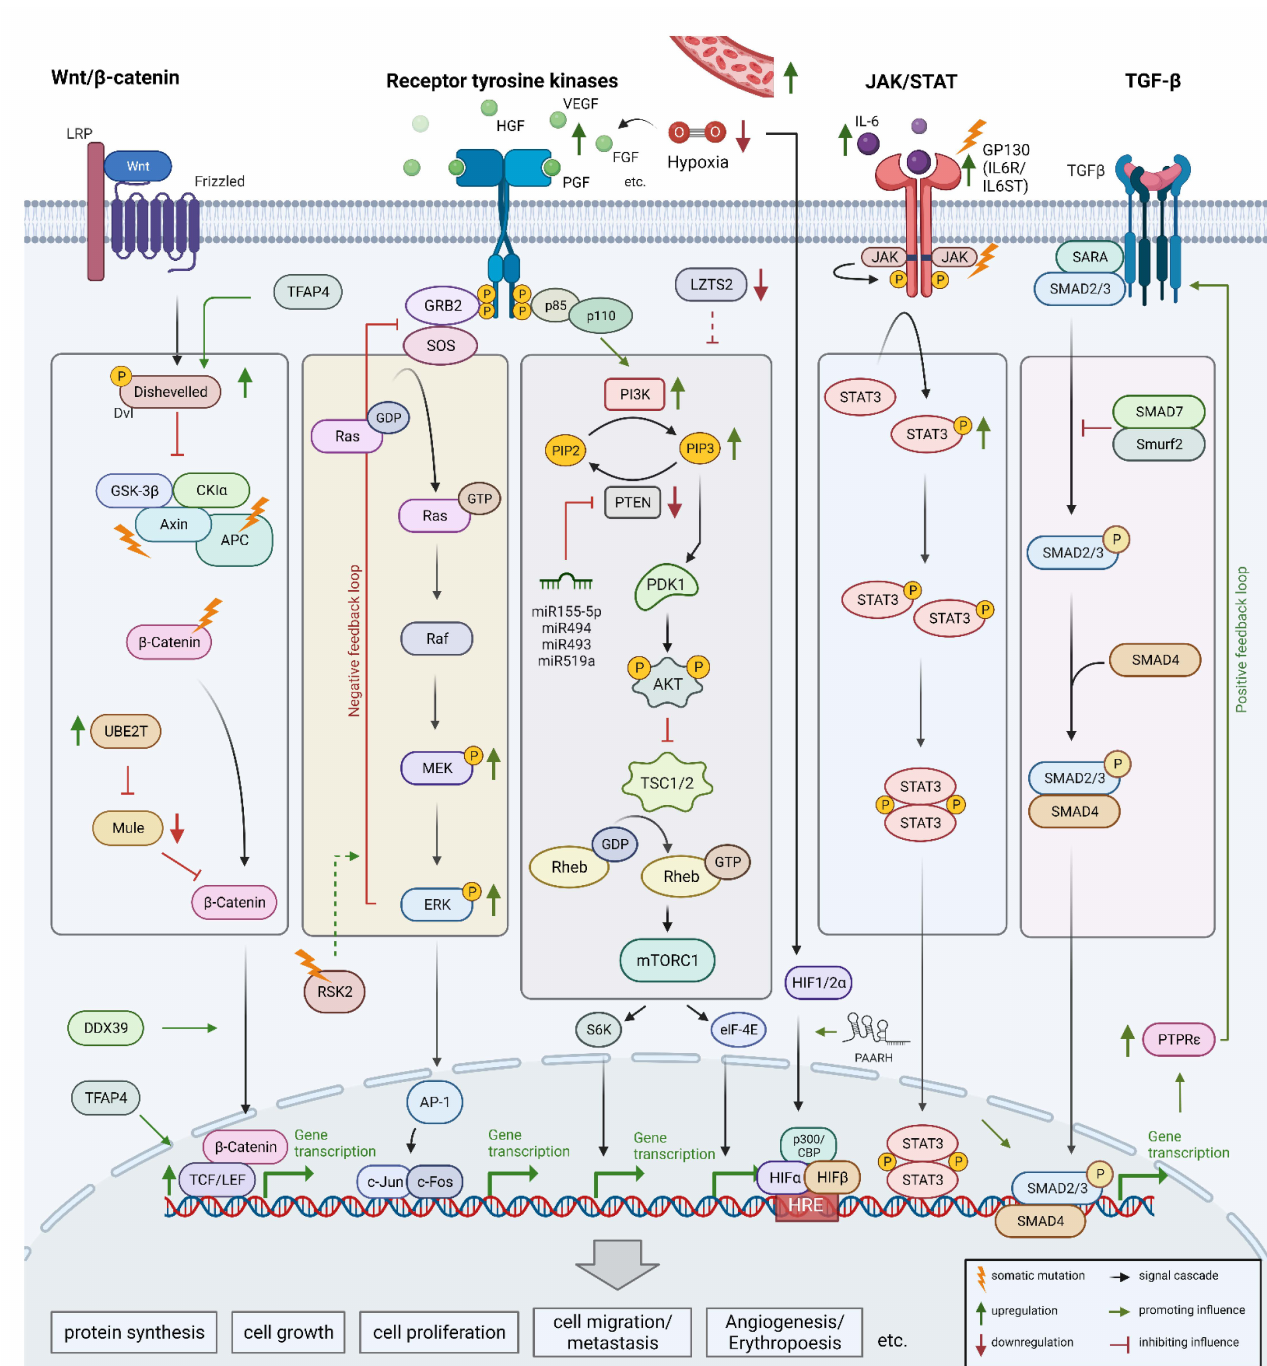
Figure 4. Most likely dysregulated key-signaling pathways are in HCC carcinogenesis. The occur- rence of distinct somatic mutations and the influence of either inhibiting or activating factors all favor the constitutive activation of significant signaling pathways. Consequently, the cell evades any regulatory mechanism and strongly promotes tumor-typical properties including cell growth, cell proliferation, migration, and metastasis. Thus, smallest changes in the finely tuned signaling cascades result in